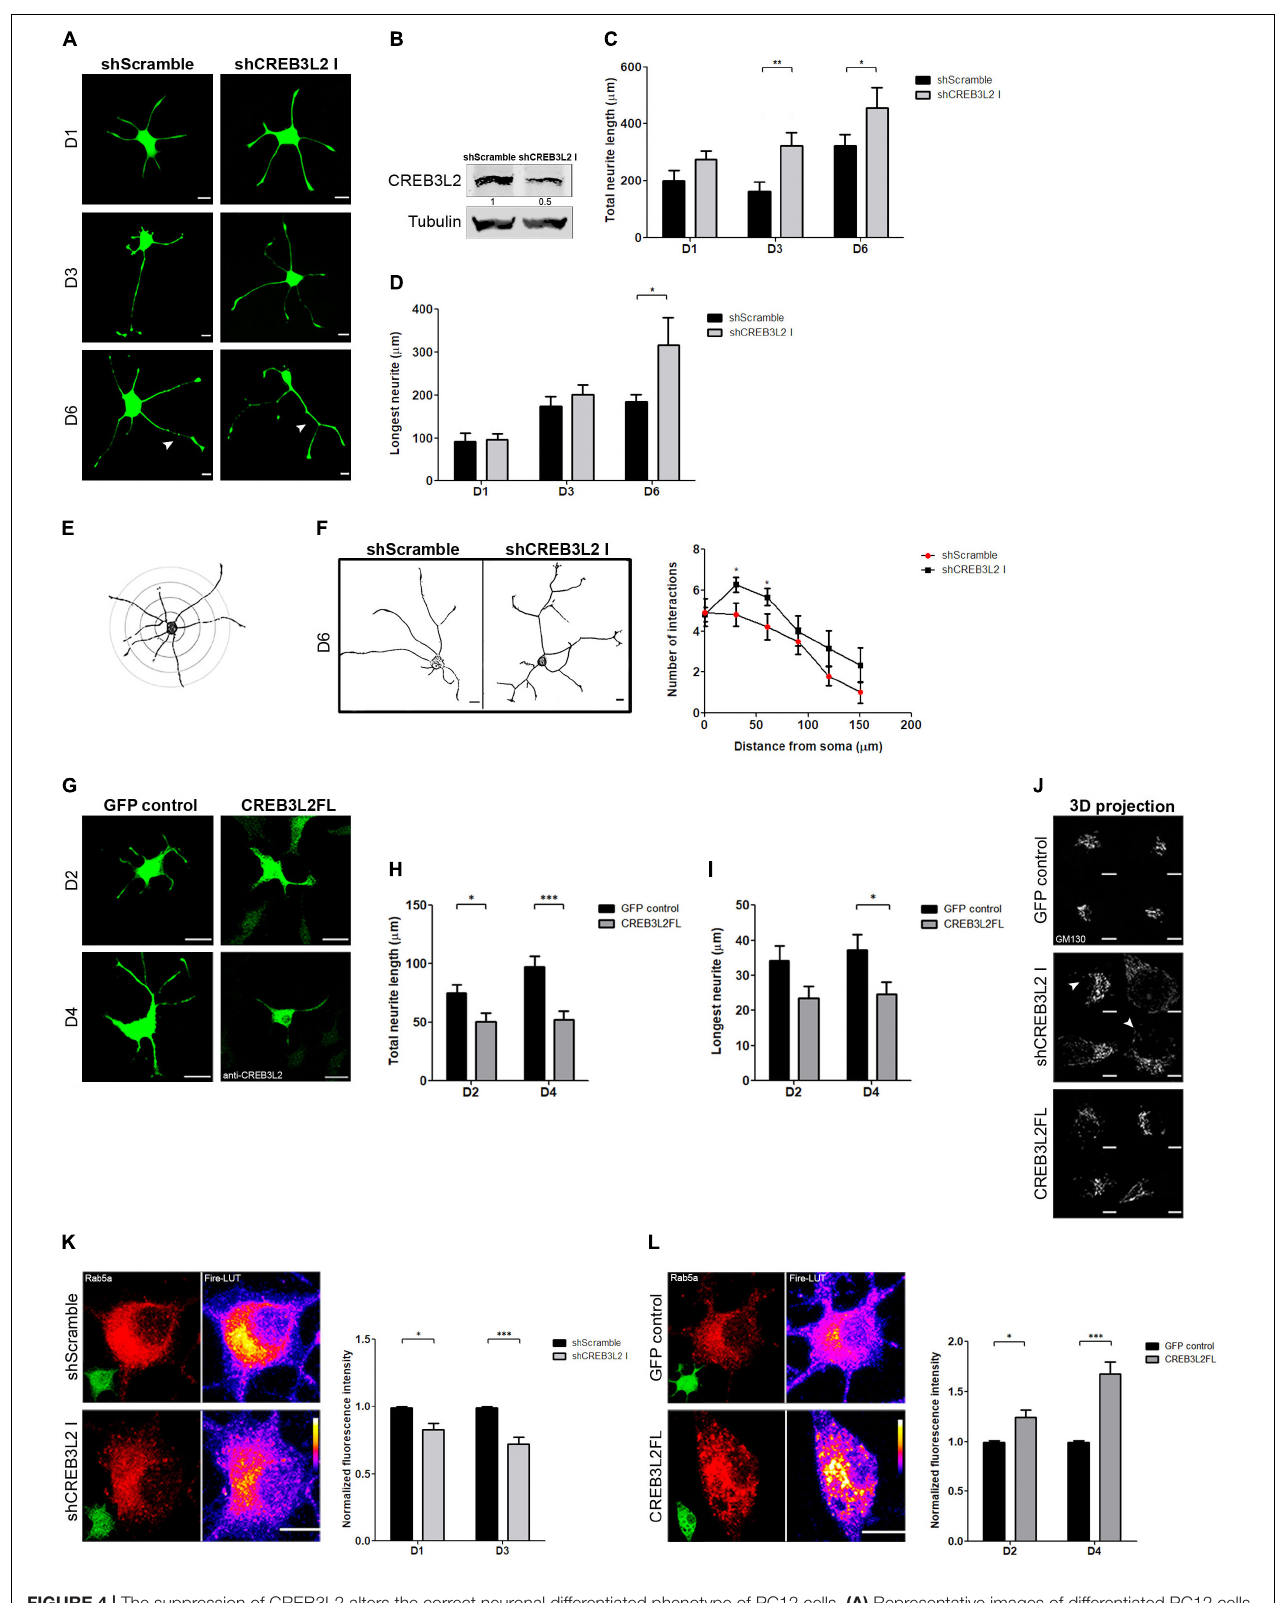
FIGURE 4 | The suppression of CREB3L2 alters the correct neuronal differentiated phenotype of PC12 cells. (A) Representative images of differentiated PC12 cells transduced with shScramble-EGFP (shScramble) or shCREB3L2-EGFP (shCREB3L2 I) and fixed at the indicated time after NGF induction. Arrowheads indicate